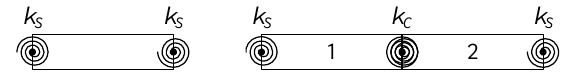
Figure 5: Concept of the finite segment method.